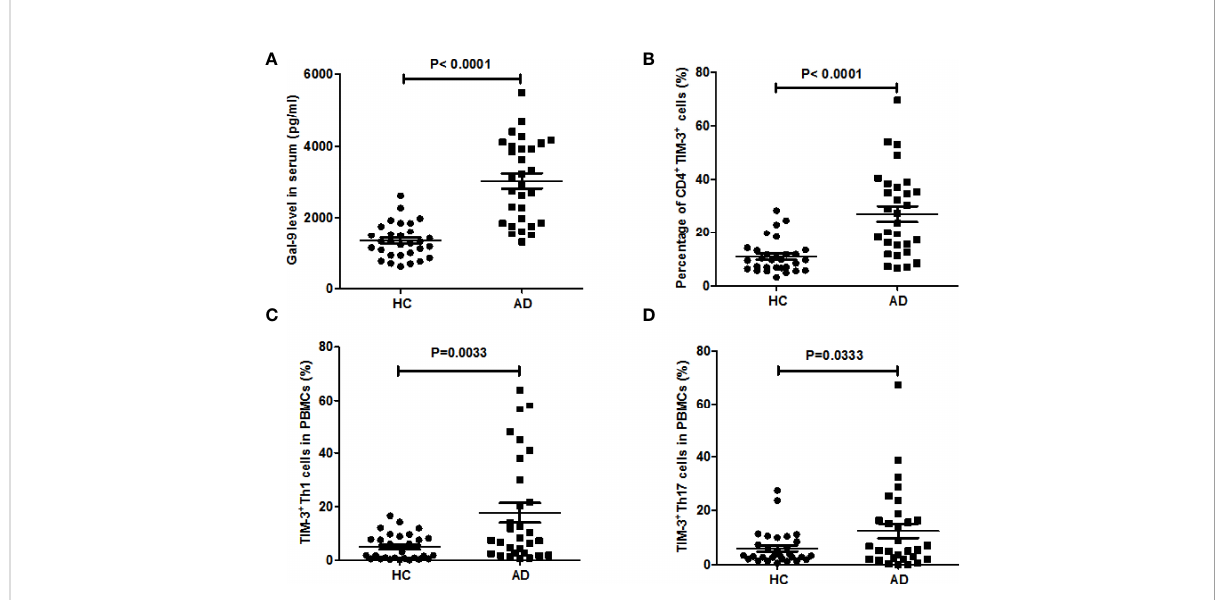
FIGURE 1 Blood levels of Gal-9 and TIM-3-positive T cells are markedly increased in patients with AD. (A) Serum Gal-9 levels of patients with atopic dermatitis involved in this study (AD, n = 30), as compared to healthy controls (HC, n = 30), (B) the percentage of CD4 + TIM-3 + T cells in whole blood, the percentage of (C) TIM-3 + T H 1 cells and (D) TIM-3 + T H 17 cells in PBMCs of the above patients with AD compared to HC. These results are presented as means ±